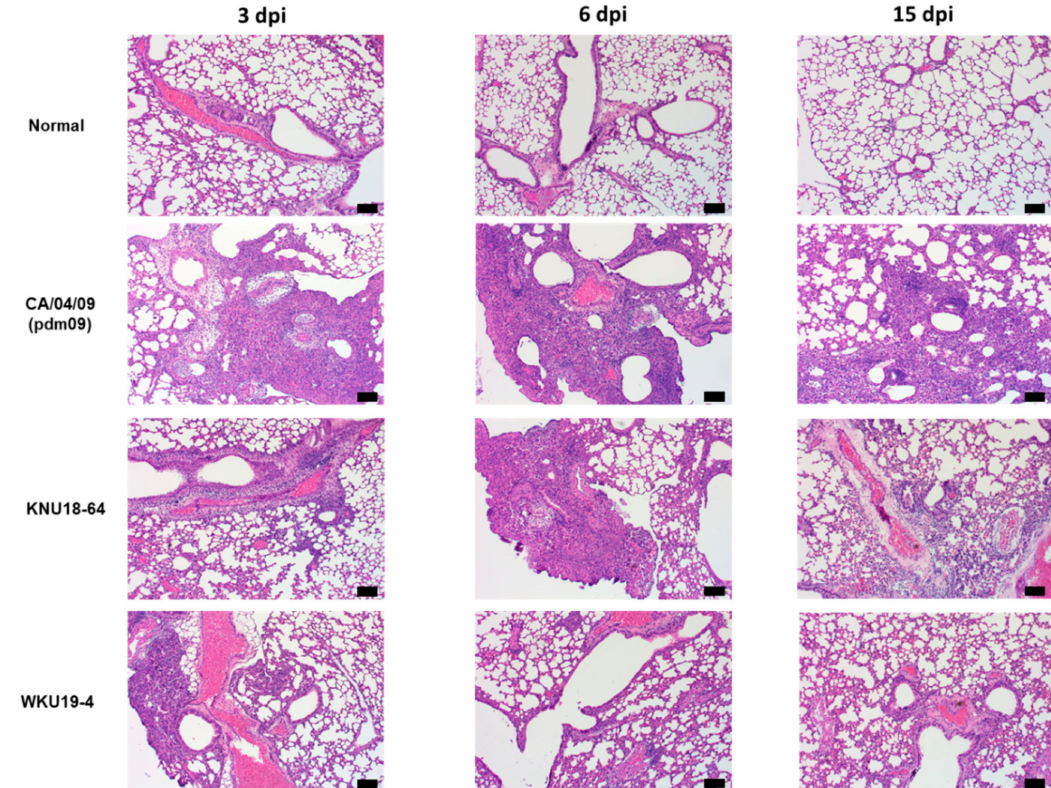
Figure 6. Histology of lung inflammation determined by hematoxylin and eosin (H&E) staining. For each isolate, BALB/c mice were intranasal infected with EID 50 concentrations of the virus at 10 5 EID 50 /mouse. The uninfected control (normal); CA/04/09(pdm09) (H1N1)-, KNU18-64 (H1N1)-, and WKU19-4 (H1N1)-infected mouse lungs were collected and stained with hematoxylin and eosin (H&E) at 3, 6, and 15 days post-infection (dpi) (scale bar, 100 µ m; original magnification ×